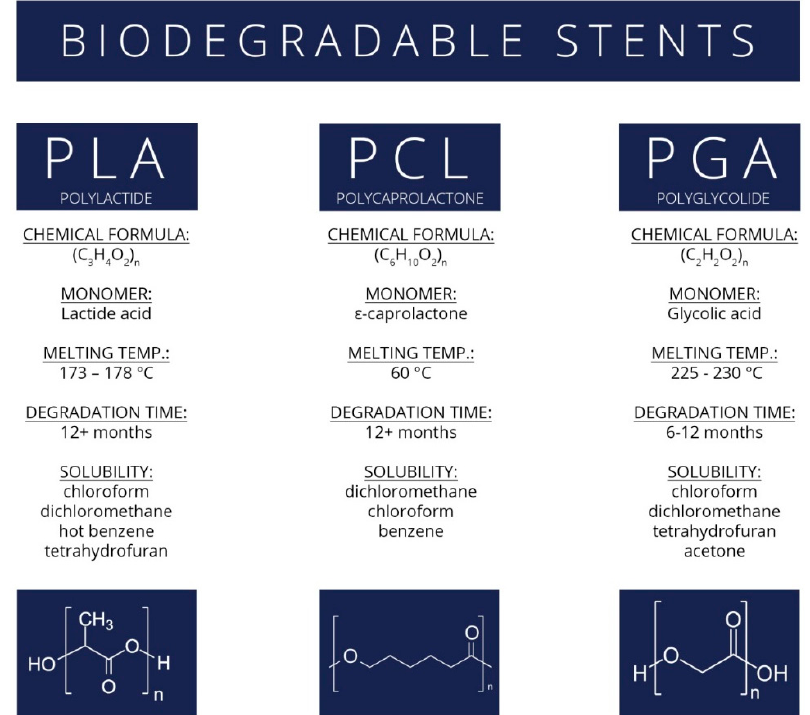
Figure 7. The main biodegradable polymers for biliary stents and some physicochemical characteristics.